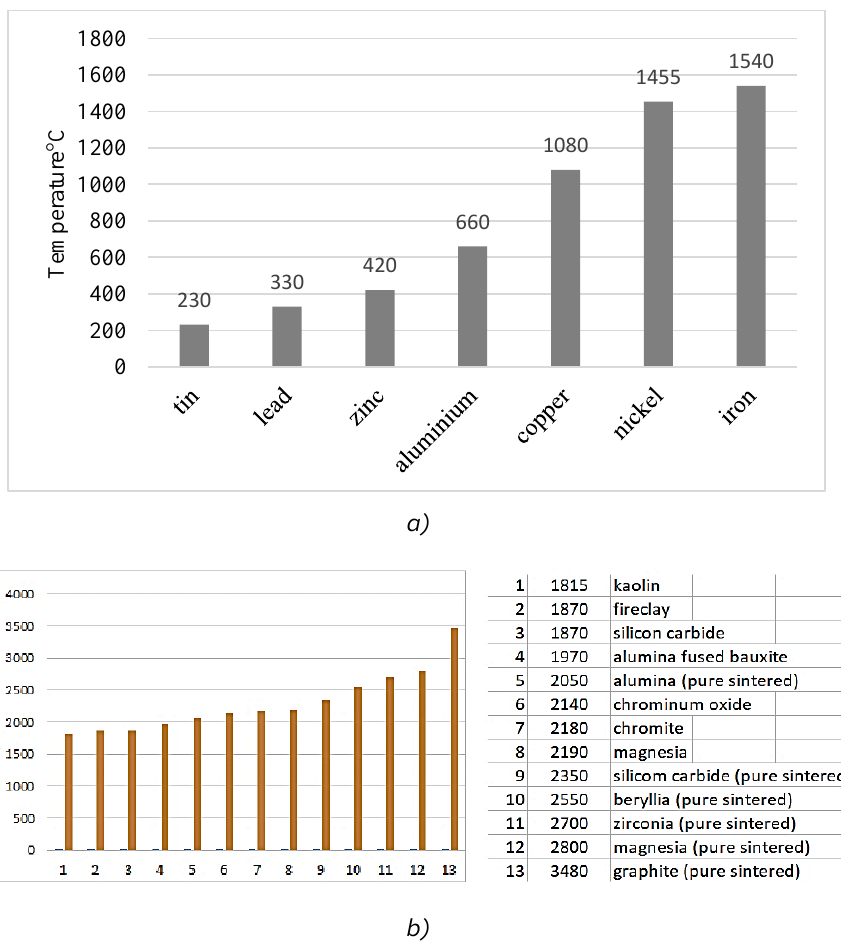
Fig. 3. Melting points of selected a) metals and alloys, b)